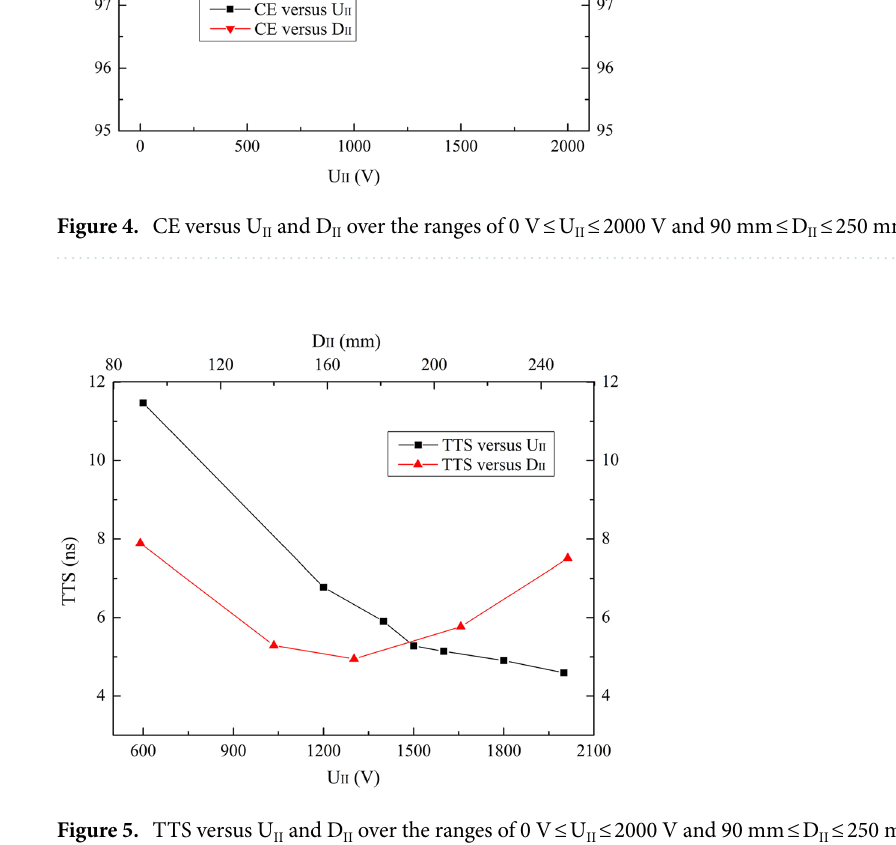
Figure 5. TTS versus U II and D II over the ranges of 0 V ≤ U II ≤ 2000 V and 90 mm ≤ D II ≤ 250